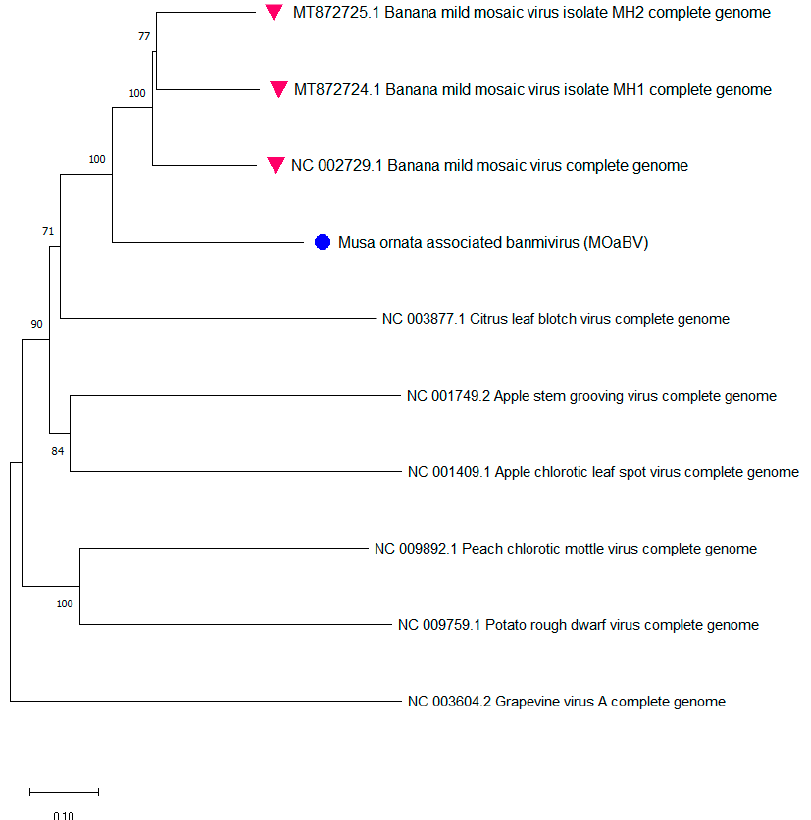
Figure 4. Neighbor-joining method phylogenetic tree inferred from full genomes of nt sequences of the new species from this study, complete genomes of BanMMV, and members from different genera of the Betaflexiviridae family. The purple triangle denotes the 3 existing complete genomes of BanMMV. The cyan dot denotes the new species identified throughout this work. Branches were bootstrapped with 1000 replications. The scale bar indicates the number of substitutions per site.